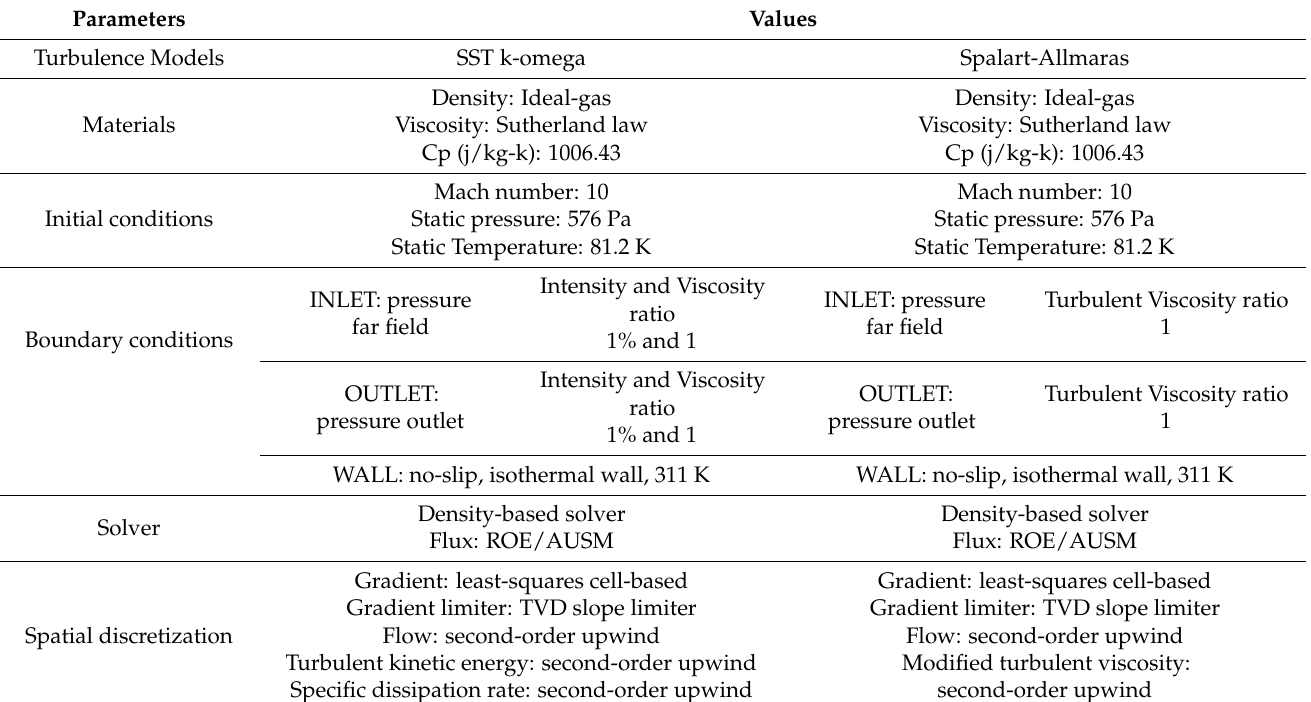
Table 8. The applied key parameters in the CFD